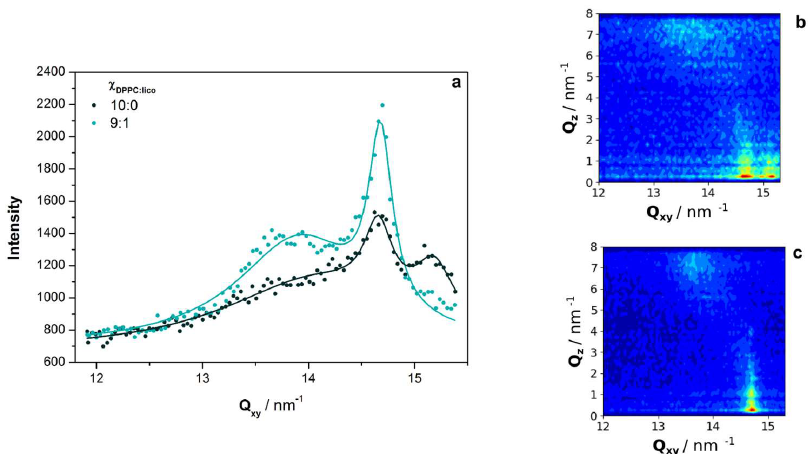
Figure 5. ( a ) Grazing-incidence X-ray diffraction (GIXD) patterns of the DPPC monolayer at pH 7.4 in the absence (X DPPC:lico 10:0) and in the presence of licofelone (X DPPC:lico 9:1) at 30 mN m − 1 . The corresponding Q xy -Q z intensity maps are also presented for ( b ) X DPPC:lico 10:0 and ( c ) X DPPC:lico 9:1. peaks, namely the lattice repeat distances ( d ), the correlation lengths ( ξ ), and the acyl chains tilt angle ( θ ). Traditionally, the first-order peak indexations are 1 1(cid:3364) (out-of-plane) and 02 (in-plane) for the tilted rectangular lattice, and 10 (in-plane) for the untilted hexagonal lattice [28]. From the Q xy -Q z